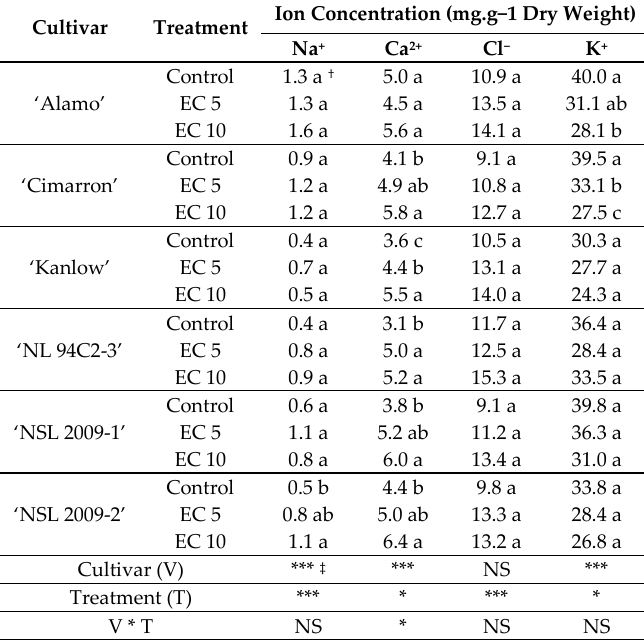
Table 2. Leaf ion concentrations of six switchgrass cultivars irrigated with a nutrient solution at an electrical conductivity (EC) of 1.5 dS·m − 1 (control) or salt solutions at EC of 5.0 dS·m − 1 (EC 5) or 10.0 dS·m − 1 (EC 10) in a